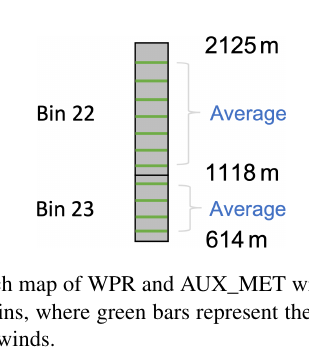
Figure 2. Geometry of Aeolus wind measurements.